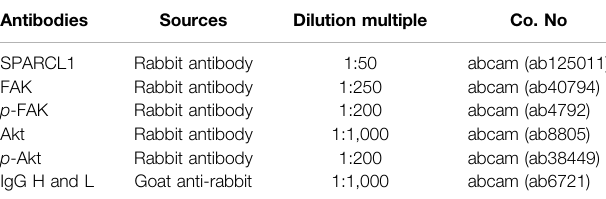
TABLE 3 | Antibodies for